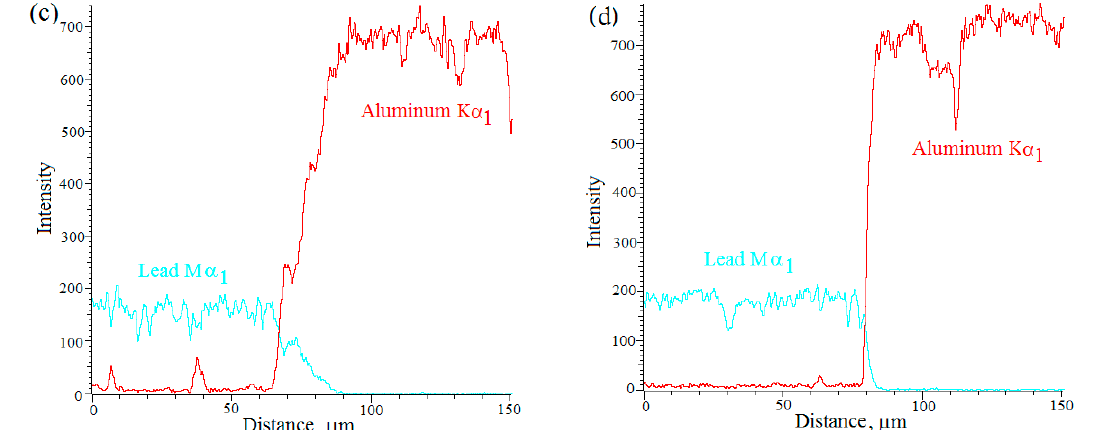
Figure 4. The analysis section and the distribution of chemical elements at the fusion boundary of the ingot ( a , c ) without treatment, and ( b , d ) after EMP processing.